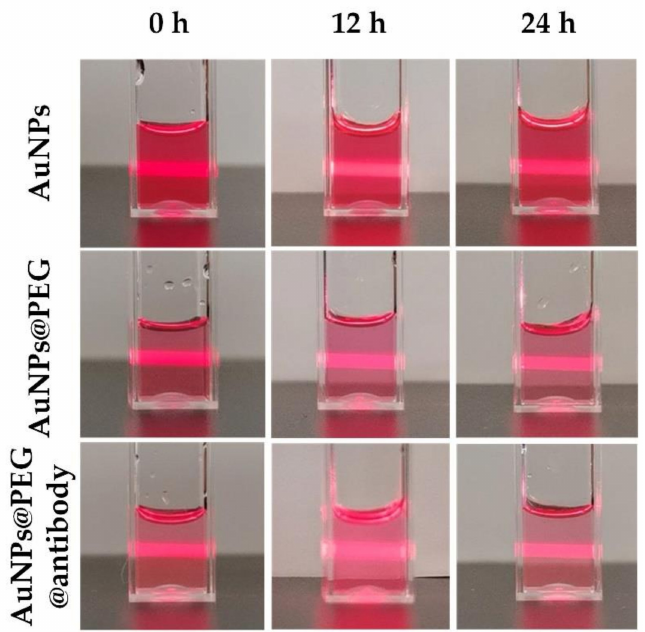
Figure 3. Photos of AuNPs, PEG-coated AuNPs and antibody@PEG-coated AuNPS solution illumi- nated by a laser beam at different time